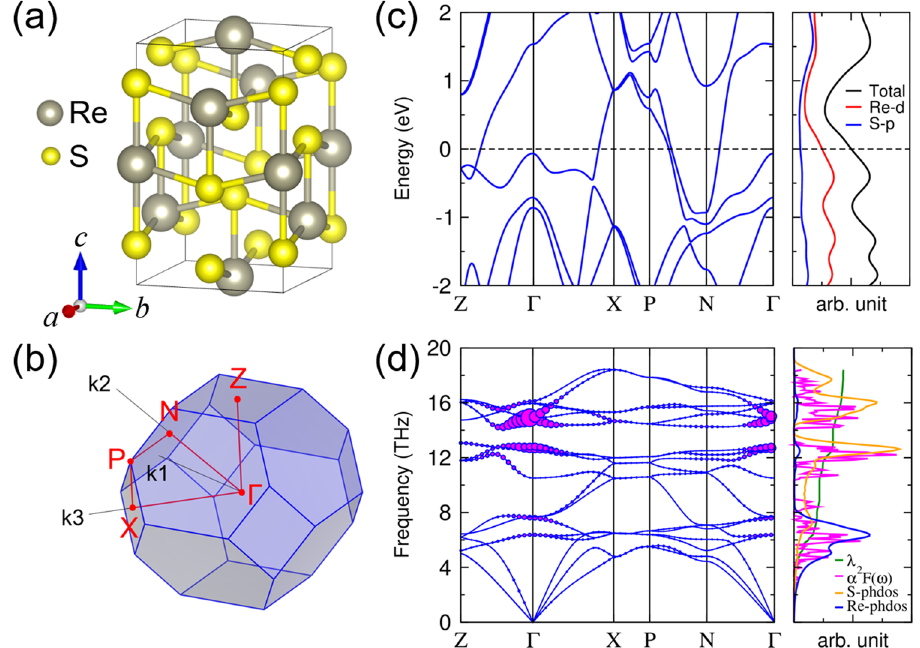
Fig. 4 The crystal structure, band and electron – phonon coupling of the I 4 1 /amd ReS 2 . a The crystal structure of I 4 1 /amd at 100 GPa. b The fi rst Brillion zone and c the calculated band structure of I 4 1 /amd ReS 2 at 100 GPa. d The calculated phonon dispersions of I 4 1 /amd ReS 2 at 100 GPa. The size of the dots represents the phonon linewidth of each mode. Partial phonon DOS, Eliashberg EPC spectral function a 2 F ( ω ), and the electron – phonon integral λ ( ω ) are also shown on the right